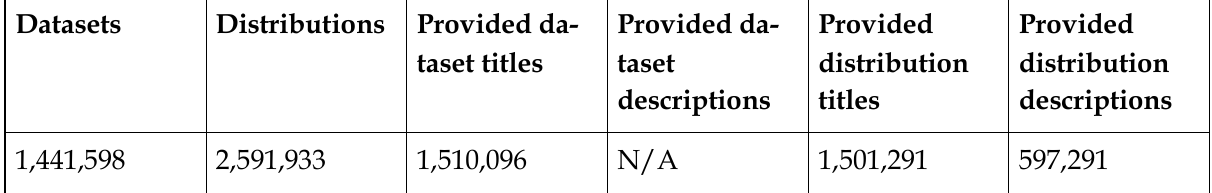
Table 1: Statics about provided metadata